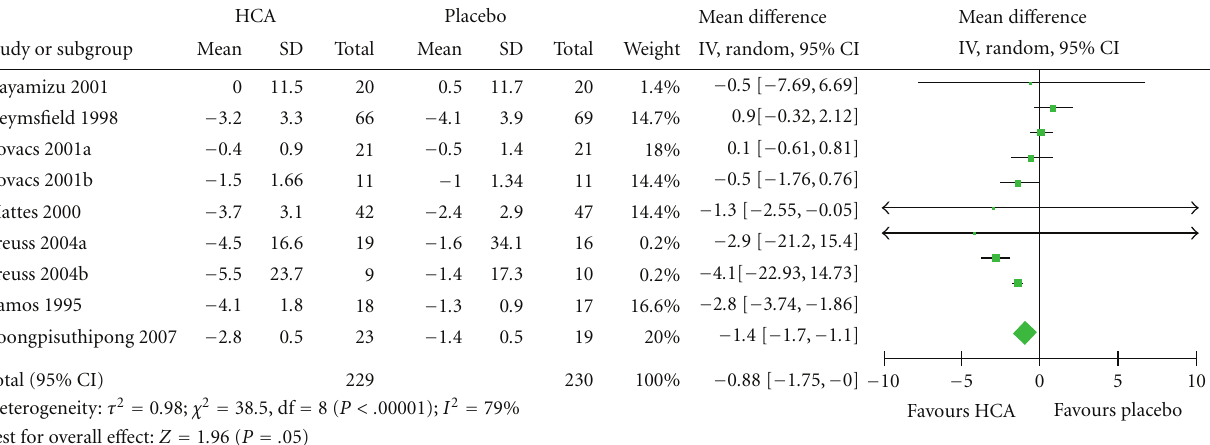
05)Heterogeneity: Test for overall e ff ect: Z = 1 . 96 ( P = . Figure 2: Forest plot of comparison showing the e ff ect of hydroxycitrate on body weight. The vertical line represents no di ff erence in weight loss between HCA and placebo.